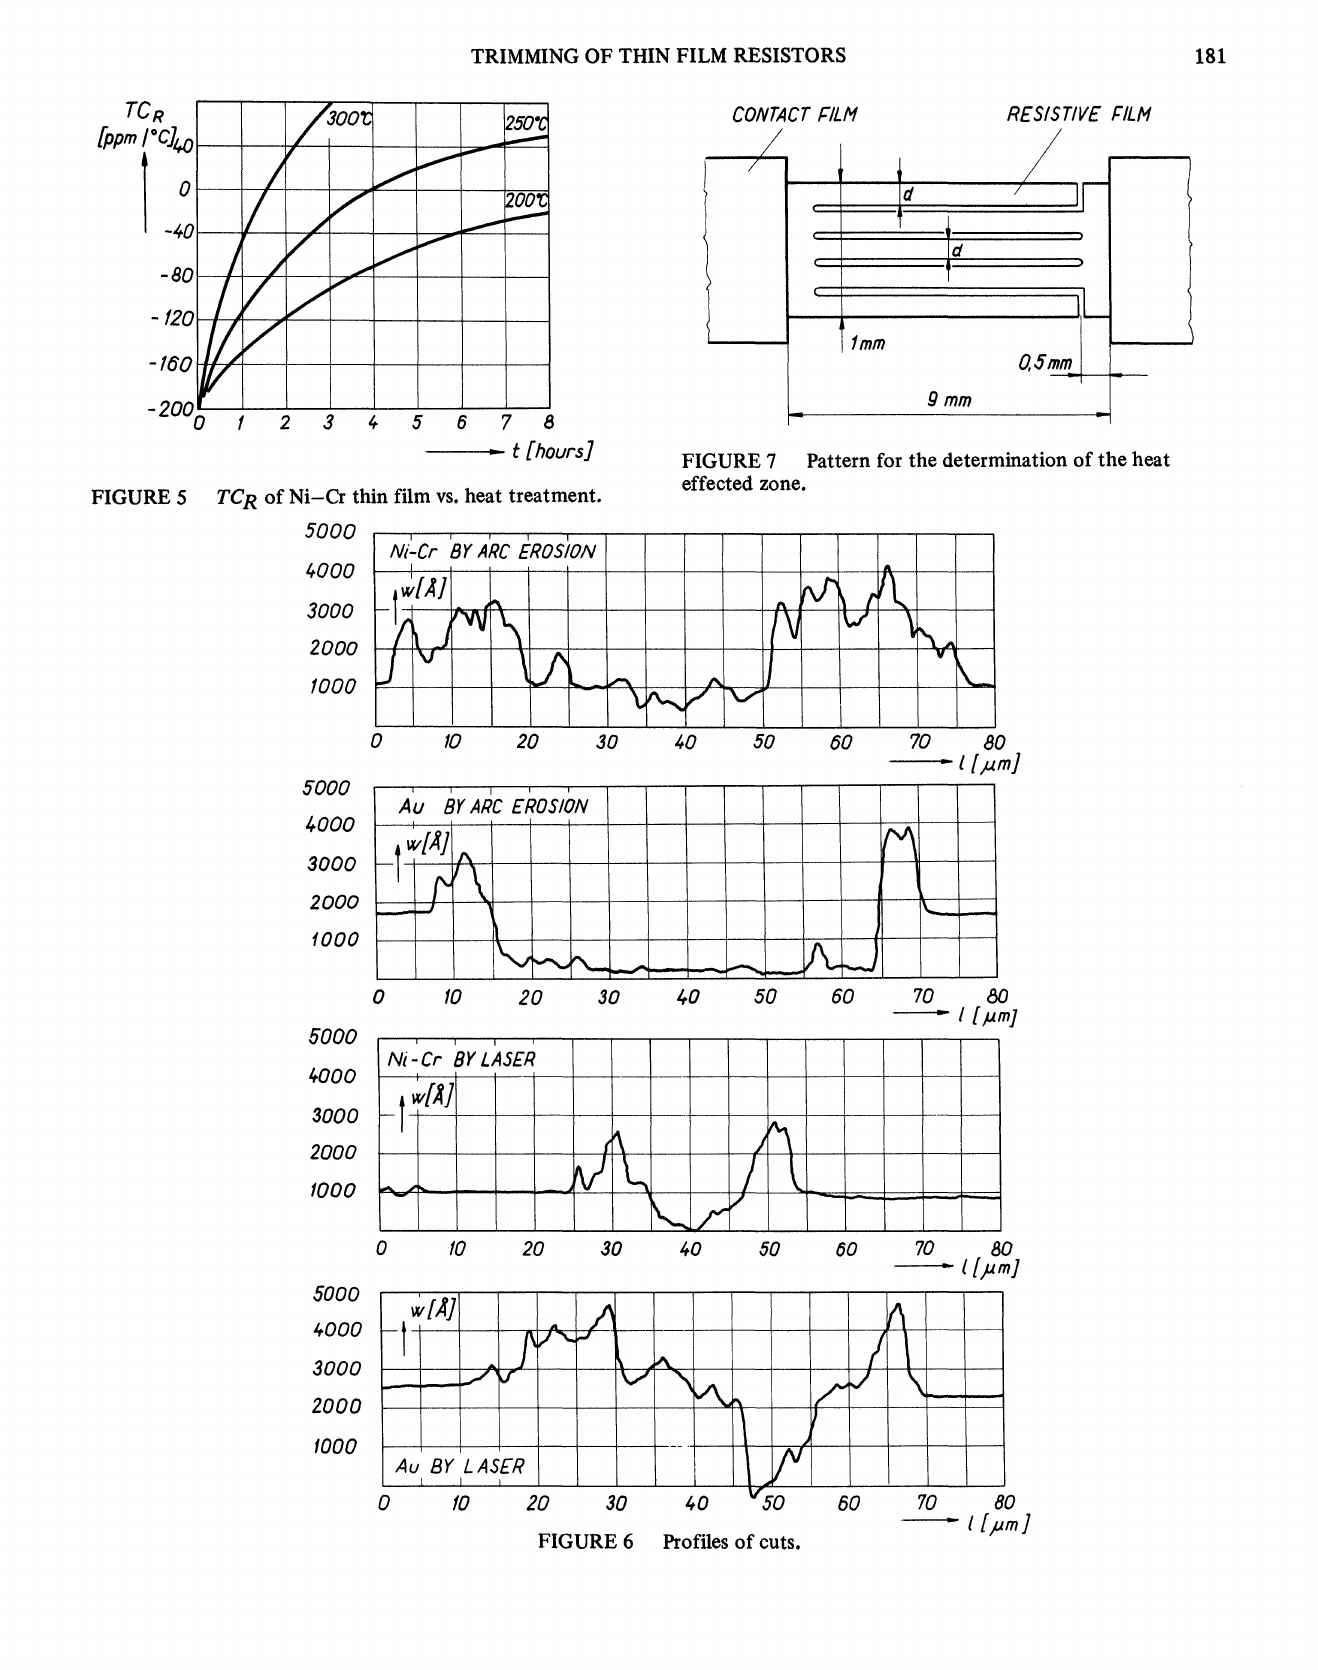
Pattern for the determination of the heat effected